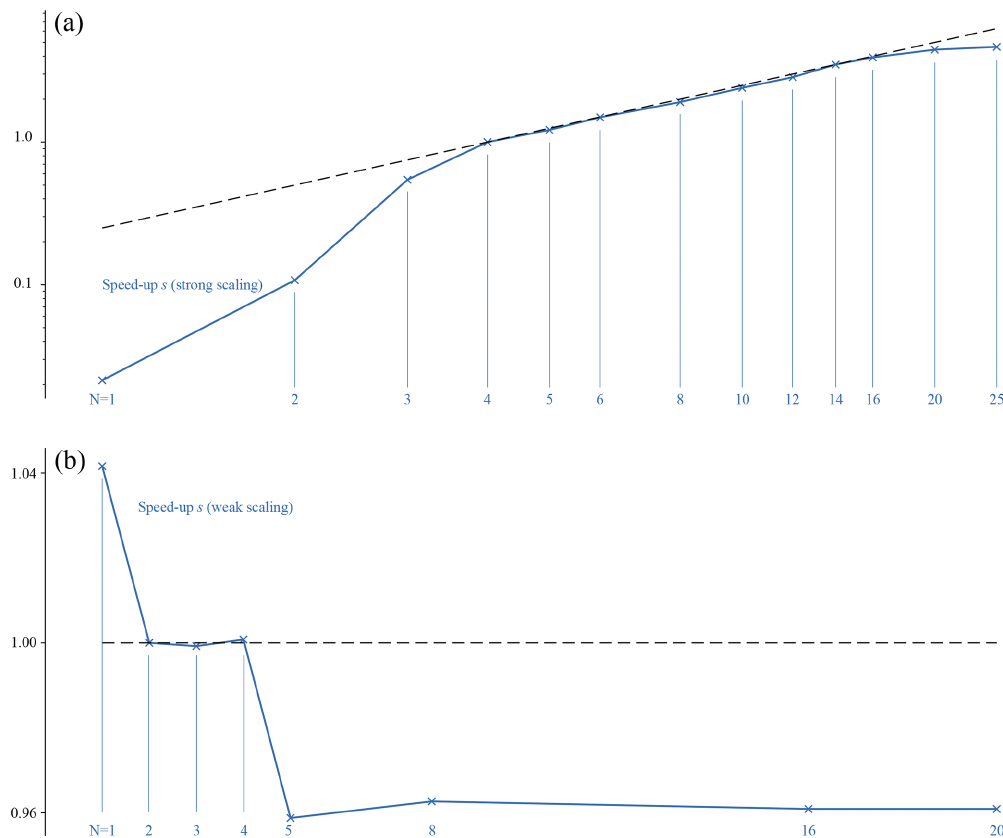
Figure 7. Results for the strong (a) and weak (b) scaling properties of Menura . The strong scaling test consists of a simulation domain of a 1000 × 1000 grid with 1000 particles per grid node, divided into an increasing number of processes (i.e. GPUs). During the weak scaling test, the load on each GPU is kept constant (1000 × 125 grid, 1000 particles per node) and the number of processes is increased. The speed-up in both cases is defined as s N = t ref /t N with here t ref = t 4